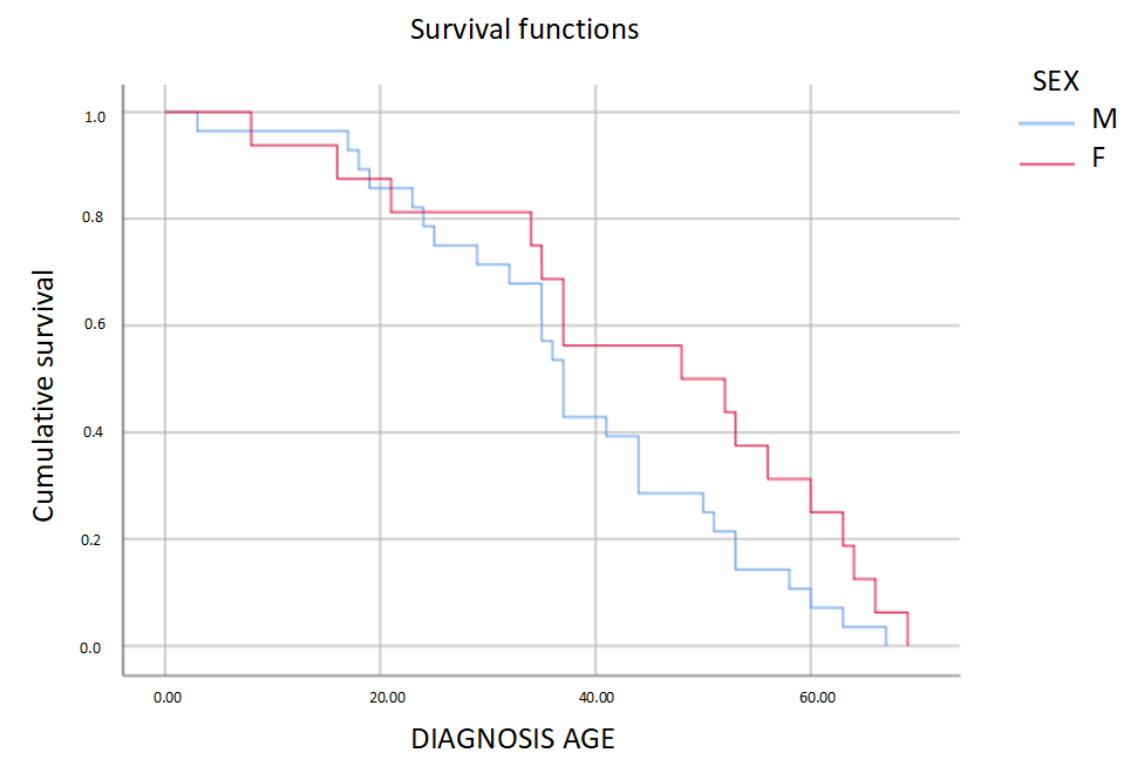
Figure 3. Log-rank test: penetrance of HCM according to age and sex in carriers of the p.Val931Glyfs* MYBPC3 mutation. In our sample, there is no statistically significant difference in the average diagnosis age of men and women ( p > 0.05).